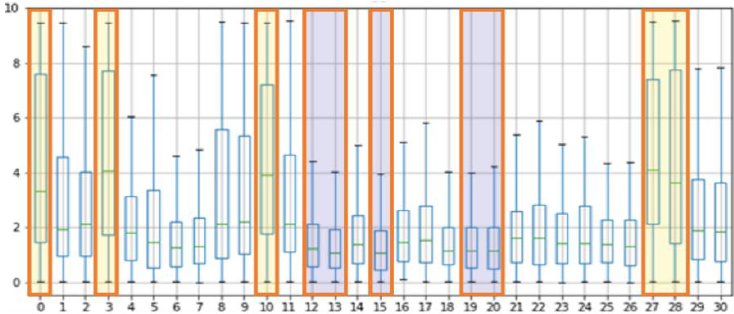
Figure 9. Evaluation of rBS in proposed regions.